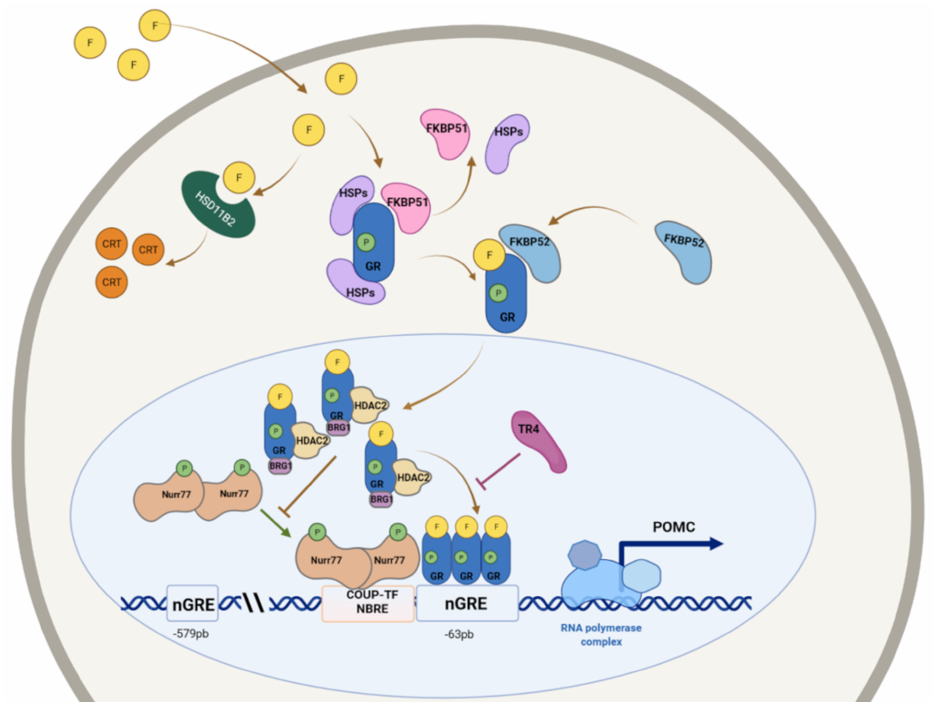
Figure 1. Graphical representation of glucocorticoid receptor (GR) action in ACTH-secreting pituitary cells and regulation of POMC expression. GR resides in the cytoplasm inactive in a multimeric com- plex with heat shock proteins (HSP90) and immunophilins (FKBP51 and/or FKBP52). After cortisol binding, GR dissociates from HSP90, and nuclear localization signal activates. Associated with corti- sol (F), GR translocates into the nucleus and combines with other two COR/GR complexes, binding to nGRE (negative Glucocorticoid Receptor Element) in the POMC promoter. GR downregulates POMC expression not by directly binding nGRE but via transrepression, antagonizing the binding of orphan nuclear receptors Nur77 and Nurr1. This mechanism also requires the recruitment of BRG1 protein and Histone deacetylase 2 (HDAC2), decreasing histone acetylation of the POMC gene and, consequently, its expression. NBRE: Nur77-binding response element; P: phosphorylated; other factors possibly involved in GC resistance: TR4 (Nuclear Receptor Subfamily 2 Group C Mem- ber 2) and HSD11B2 (Hydroxysteroid 11-Beta Dehydrogenase 2), which converts F to the inactive cortisone